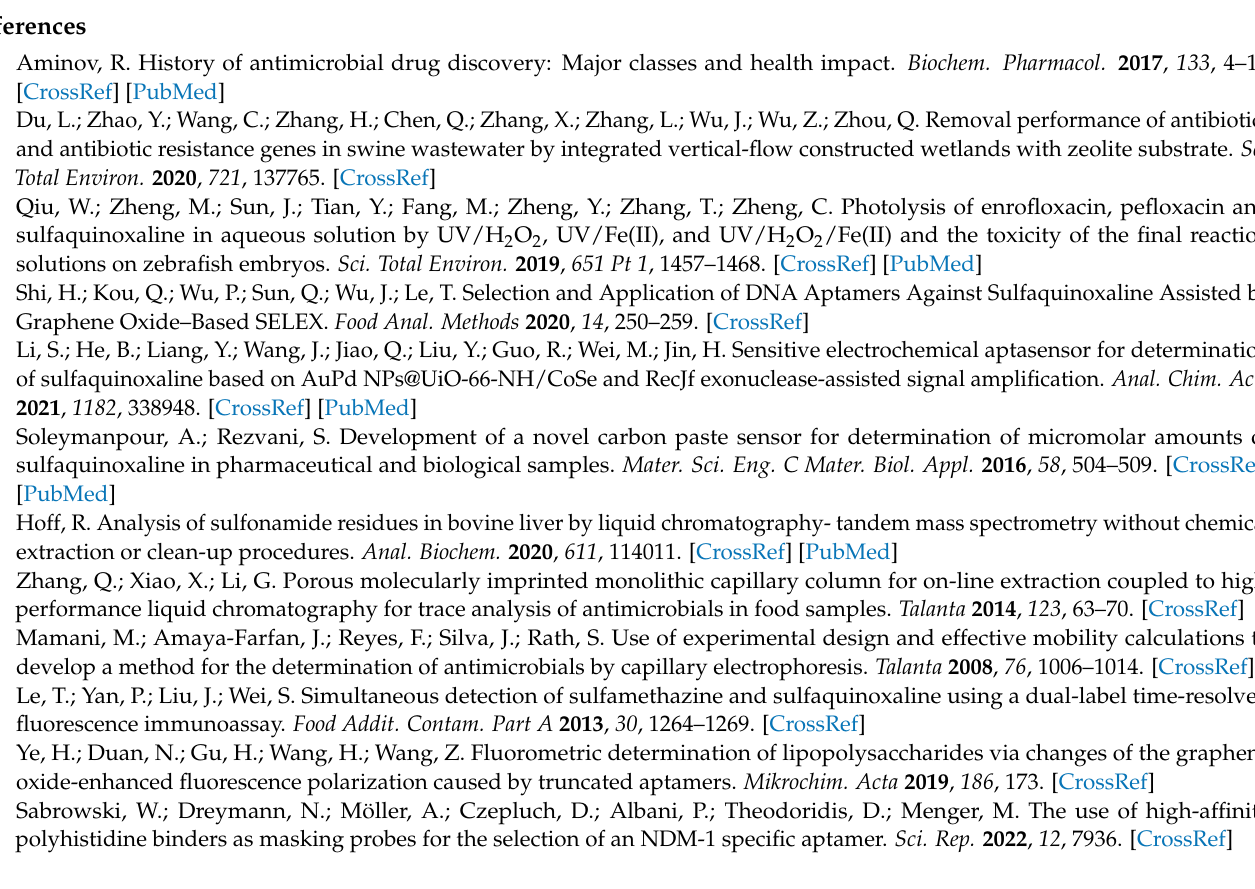
aptamers in family III. Figure S5 Secondary structure of aptamers in family IV. Figure S6 Secondary structure of aptamers in family V. Figure S7 Secondary structure of aptamers in family VI. Figure S8 Dynamic light scattering (DLS) of AuNPs in different substances. (A) AuNPs; (B) SQX-AuNPs; (C) SBA28-1-AuNPs; (D) AuNPs-NaCl; (E) SBA28-1-AuNPs-NaCl; (F) SQX-SBA28-1-AuNPs-NaCl. Figure S9 (A)Fluorescence spectra of RhoB with the absence of AuNPs in different sample solutions; (B) Fluorescence spectra of RhoB with the absence of NaCl in different sample solutions. Figure S10 (A) The effect of NaCl incubation time on the absorbance ratio in the fluorescent aptasensor; (B) The effect of NaCl concentration on the absorbance ratio in the fluorescent aptasensor; (C)The effect of SBA28-1 concentration on the absorbance ratio in the fluorescent aptasensor; (D) The effect of RhoB concentration on the fluorescence intensity in the fluorescent